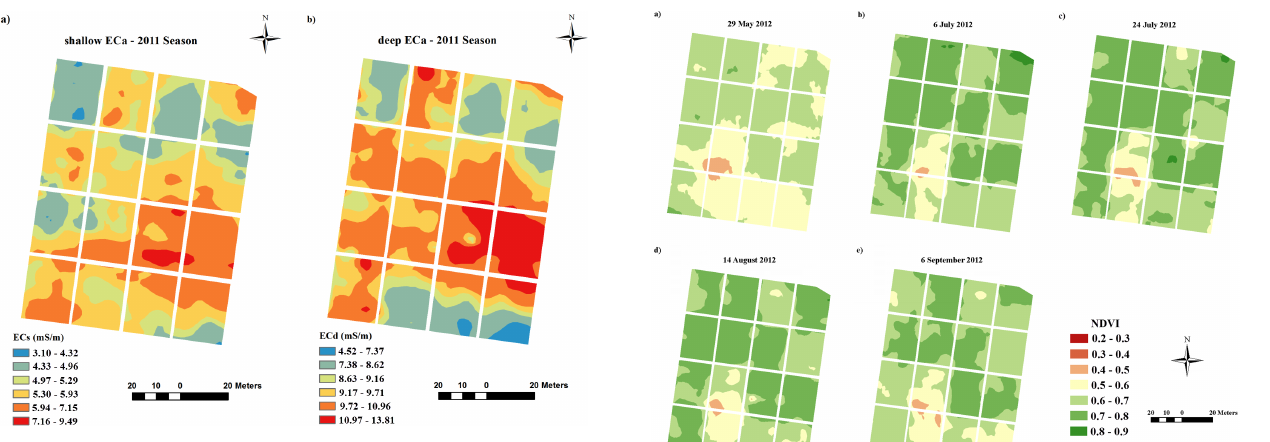
Figure 7. Interpolated apparent electrical conductivity maps of 2011 growing season: (a) shallow ECa map and (b) deep ECa map.